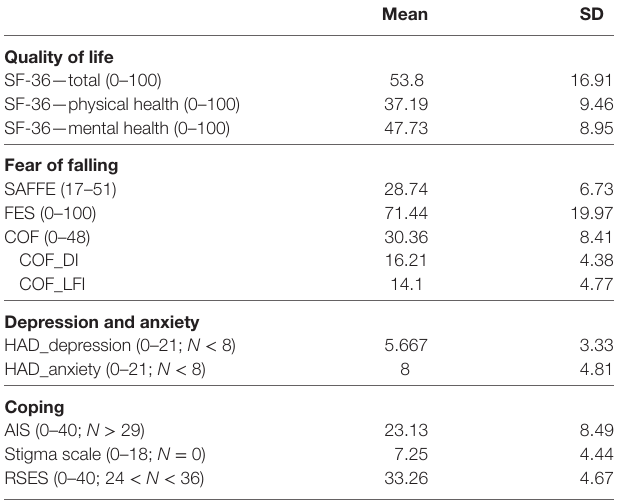
TaBle 2 | Evaluation of health-related quality of